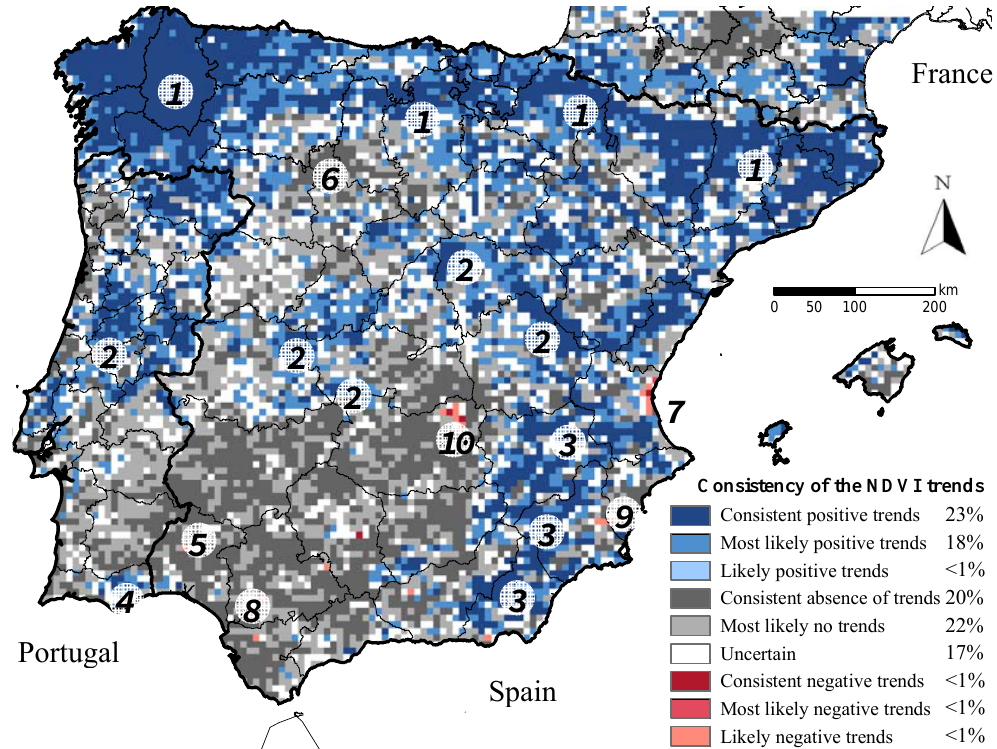
Figure 2. Consensus map showing the spatial consistency of the significant NDVI trends across the four datasets (PAL-II, FASIR, GIMMS, and LTDR) for the Iberian Peninsula. See Table 2 for legend explanation. Significant trends were considered for p-values <